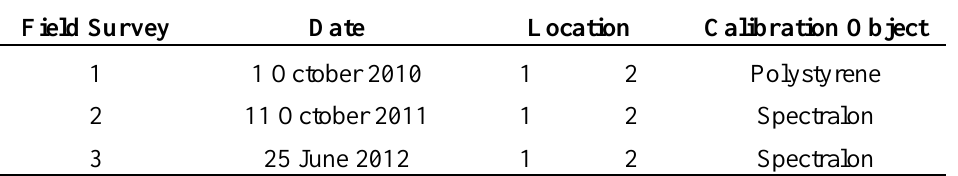
Table 1. Dates of the Sacco river field